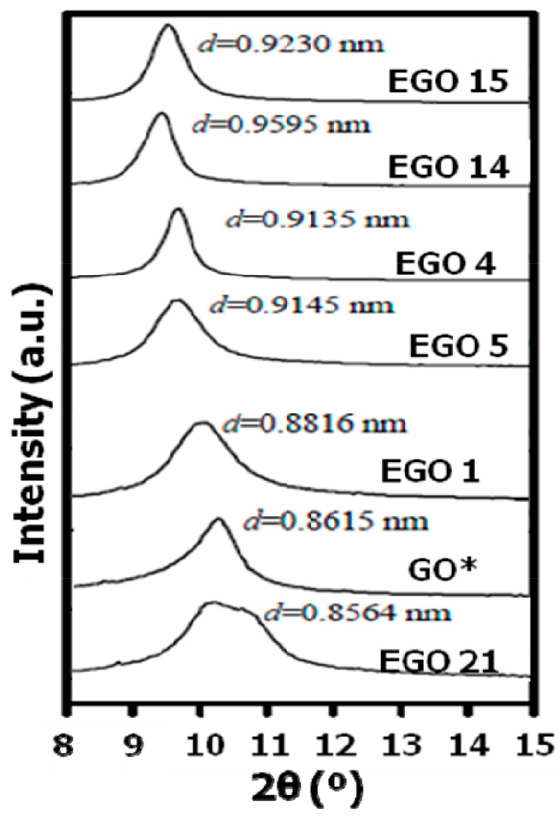
Figure 6. X-ray di ff ractogram of the reference (GO*) and the indicated EGO